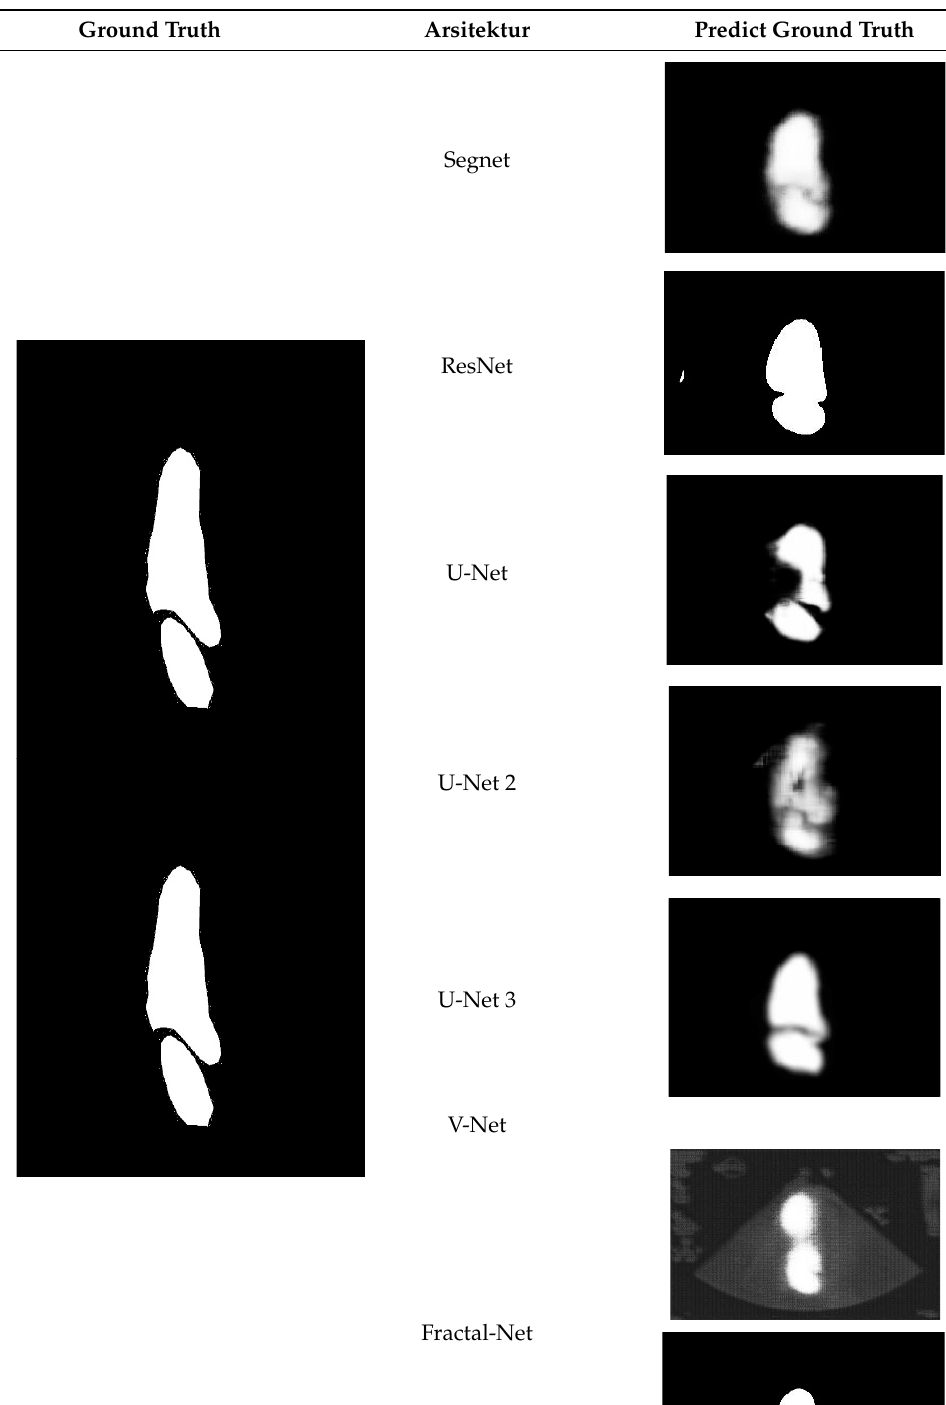
Table 8. Comparison between ground truth and predicted frame from each architecture.